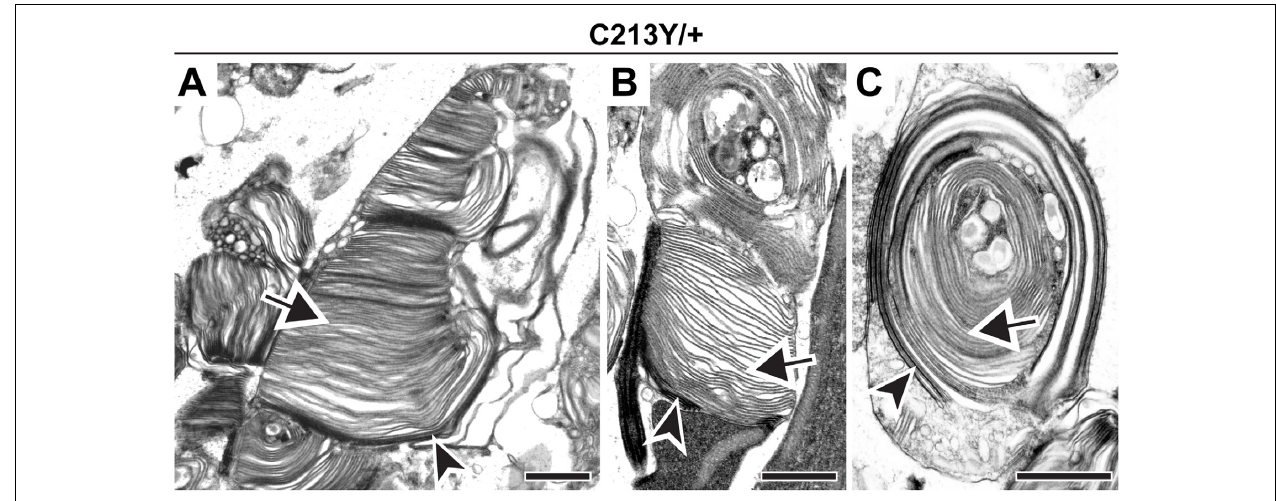
FIGURE 4 | Expression of C213Y PRPH2 disrupts outer segment structure without preventing disc enclosure. (A–C) TEM of photoreceptor outer segments of 30-day old heterozygous C213Y (C213Y/+) mice stained with tannic acid. Over 100 different outer segments from two mice were analyzed. For all images, arrowheads mark darkly stained open discs while arrows mark lightly stained enclosed discs. Scale bars are 1 µ m.